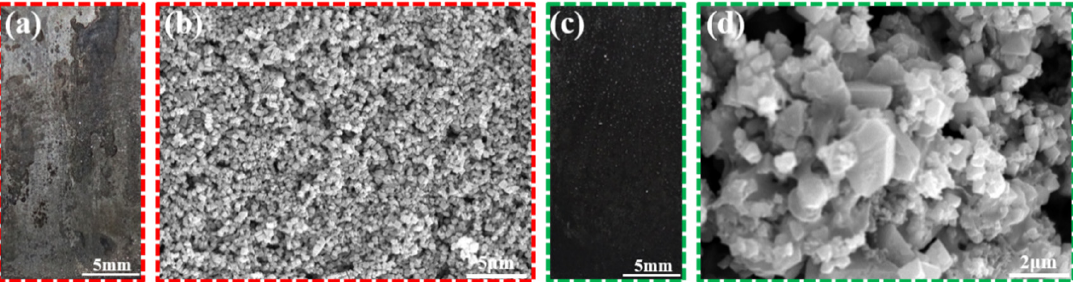
Figure 11. Macro ‐ morphology and micro ‐ morphology of T95 steel used for packer in gas ( a , b ) and Figure 11. Macro-morphology and micro-morphology of T95 steel used for packer in gas ( a , b ) and liquid ( c , d ) phase. liquid ( c , d )